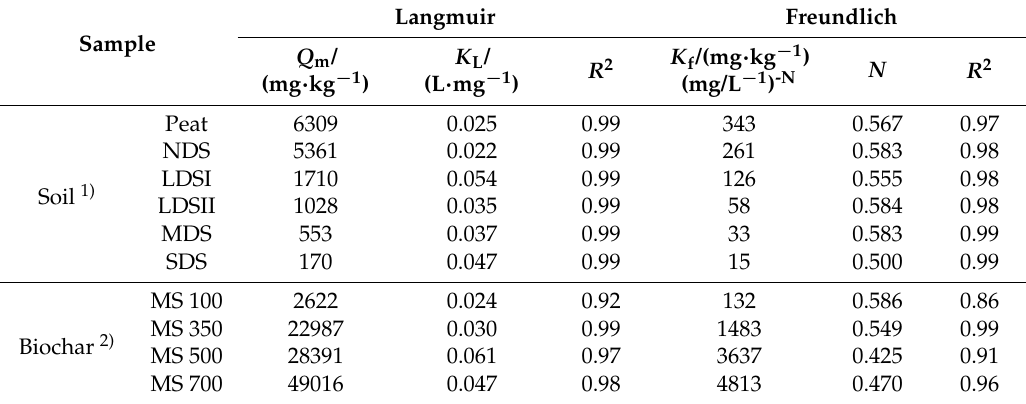
Figure 5. The relationship between the maximum adsorption capacity of cadmium on the six selected soils and TOC in the soils.